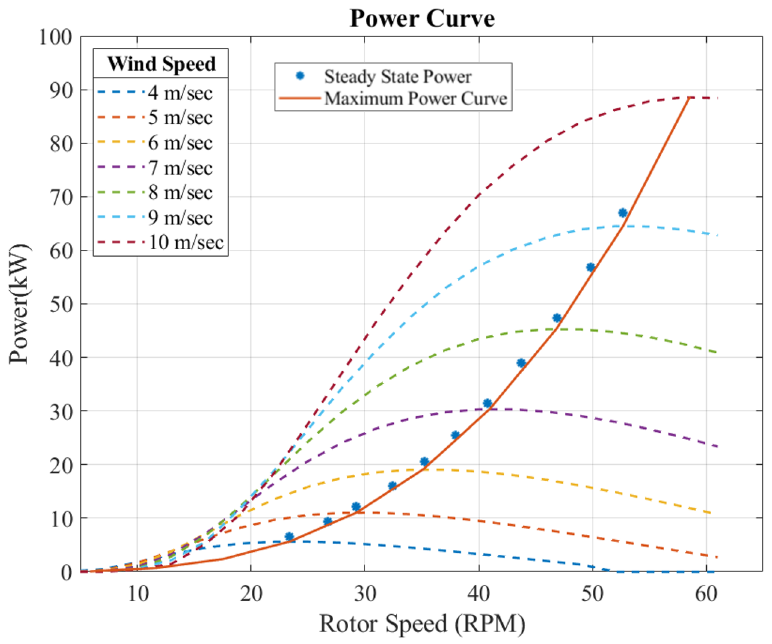
Figure 11. Rotor power at steady wind measured on the